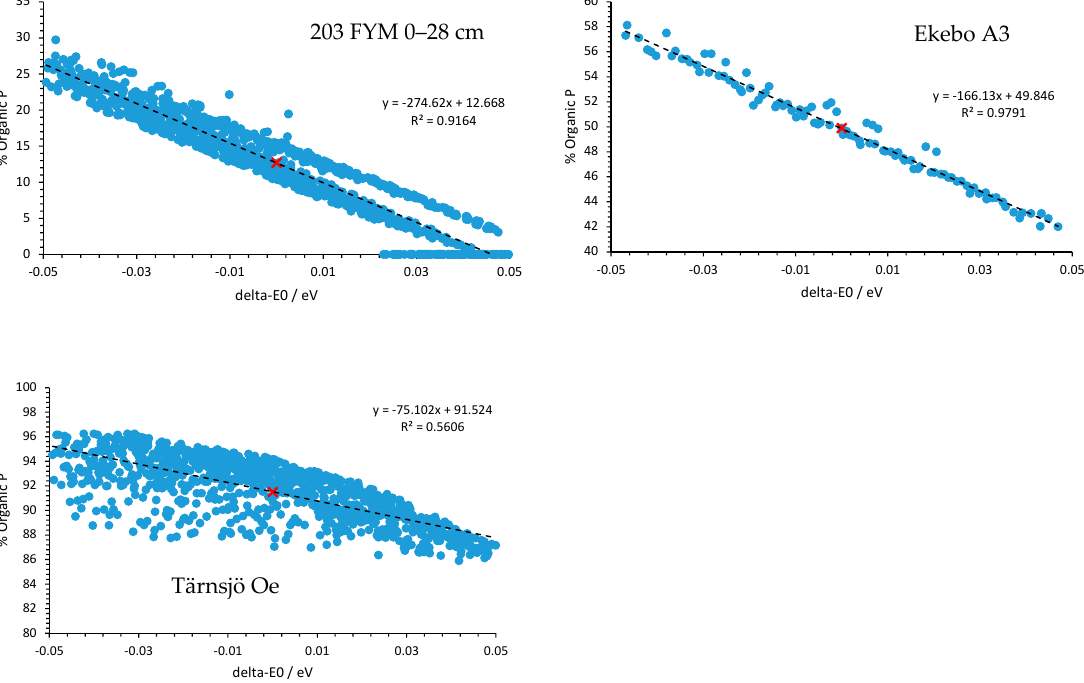
Figure 3. LCF-fitted percentage of organic P as a function of the error in calibrated energy ( ∆ E 0 ) for three different soils. For 203 FYM 0–28 cm and Tärnsjö Oe, 1000 data points were sampled, whereas the figure for Ekebo A3 is based on 100 data points. The cross denotes the mean value as reported in Table